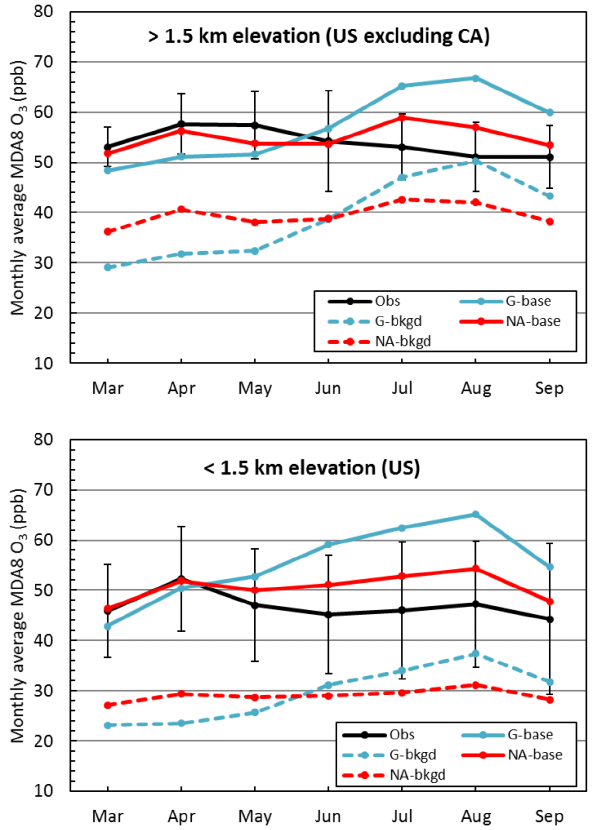
Figure 4. Observed and modeled monthly average MDA8 O 3 at high- and low-altitude CASTNet sites in 2010. G-base and G- bkgd are the GEOS-Chem global model base and background cases whereas NA cases are the CAMx North American model. Error bars for observations indicate 1 standard deviation. Site locations are shown in Fig.